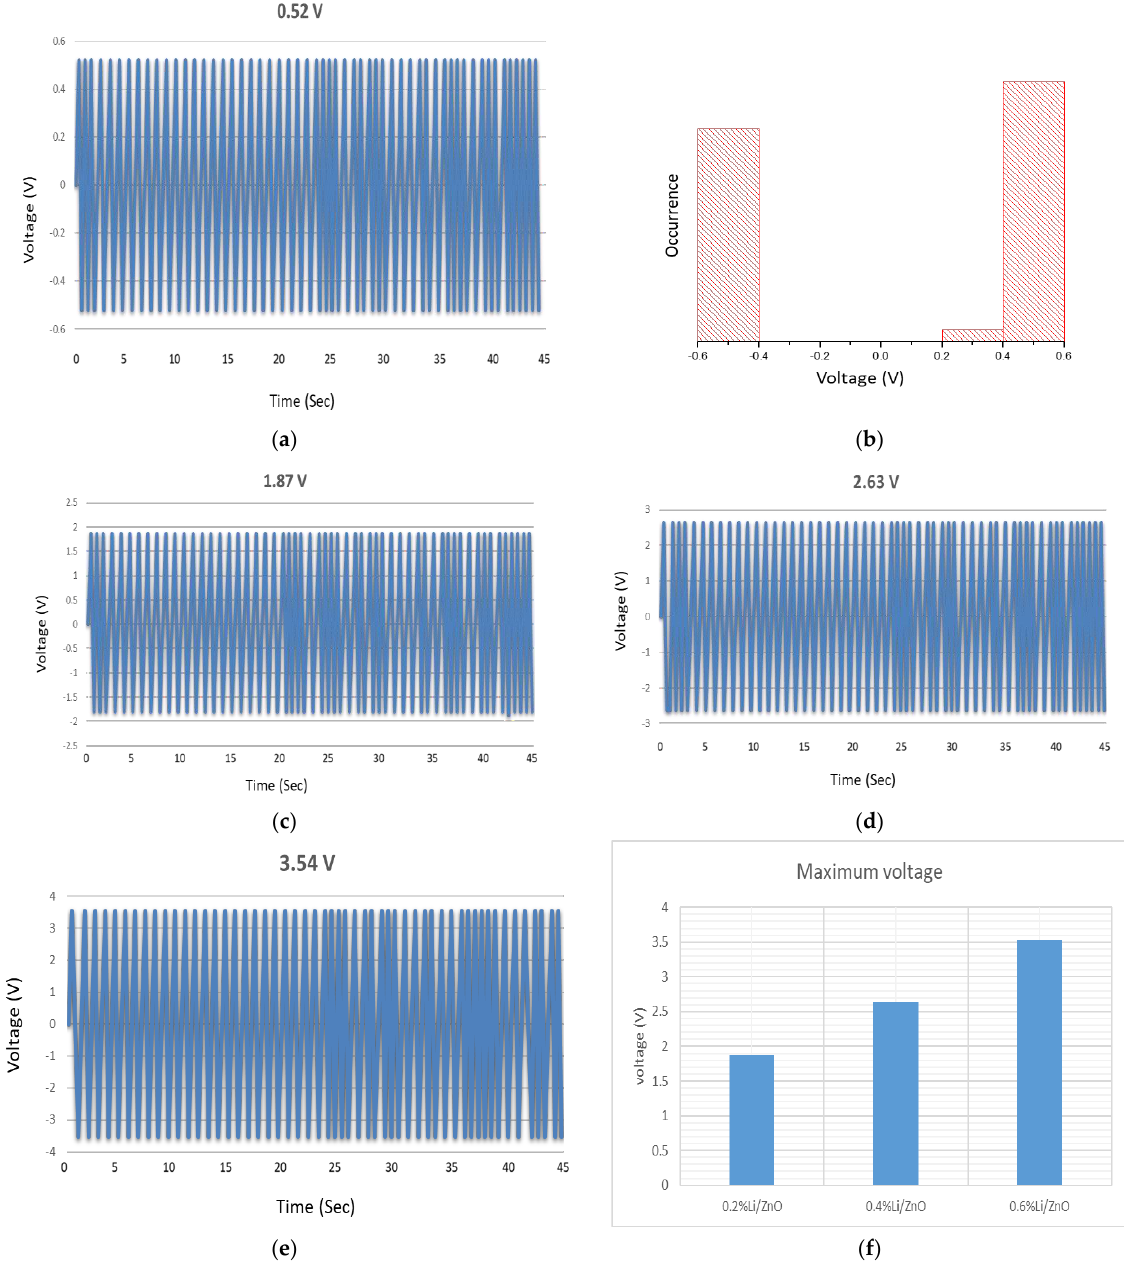
Figure 8. Output voltage values generated by ZnO nanowires based VING, ( a ) as-grown, ( c ) 2% Li/ZnO ( d ) 4% Li/ZnO ( e ) 6% Li/ZnO, ( b ) voltage histogram, and ( f ) voltage bar graph for various Li doping concentrations.